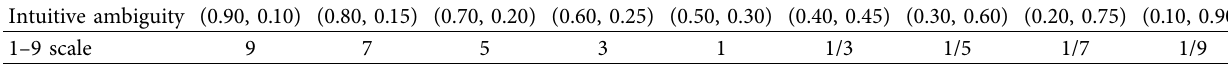
Table 10: Correspondence between the 1–9 scale and the intuitionistic fuzzy values.